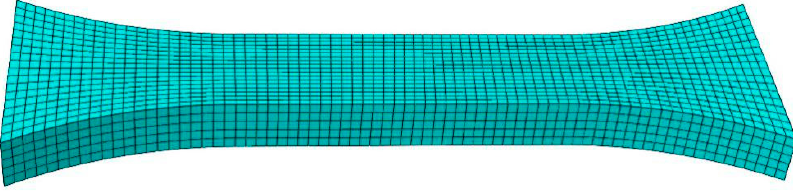
Figure 9. Meshed joint.